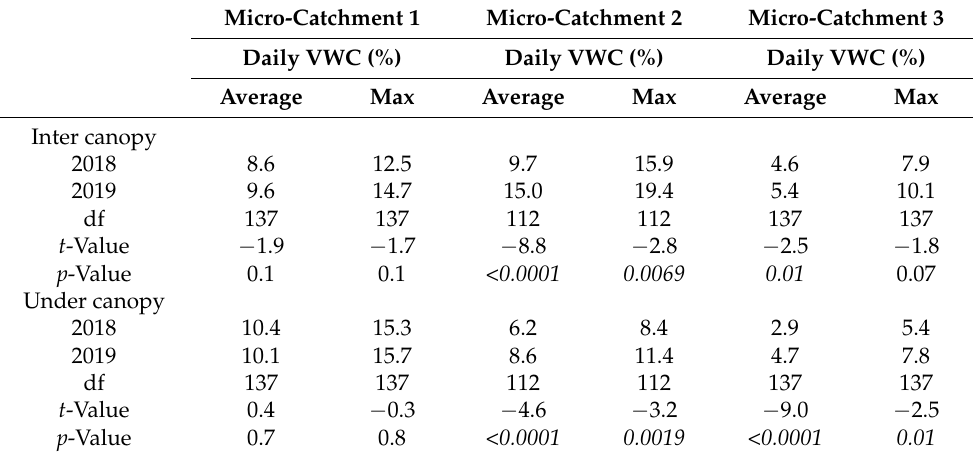
Table 5. Soil moisture differences (daily average and maximum values) between before thinning (2018) and after thinning (2019) for inter canopy and under canopy scenarios in the three